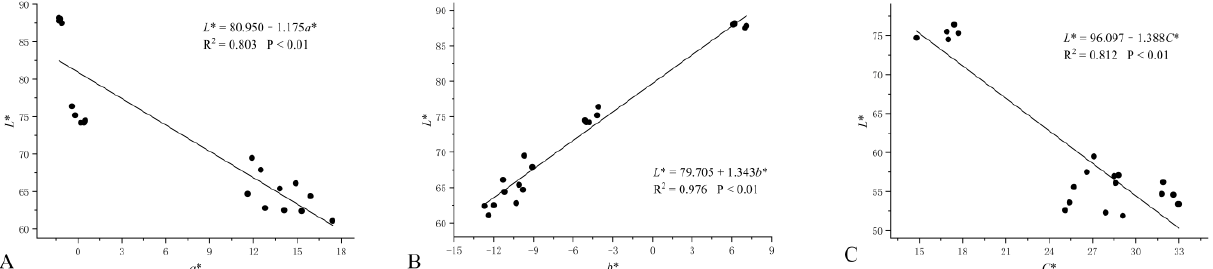
Figure 4. The linear regression between L * and a * ( A ), L * and b * ( B ) in the purple group of Hibiscus syriacus ( B ), and L * and C * ( C ) in the red-purple group of Hibiscus syriacus . Each solid circle in each panel was the mean value of five replicates of each cultivar of Hibiscus syriacus .